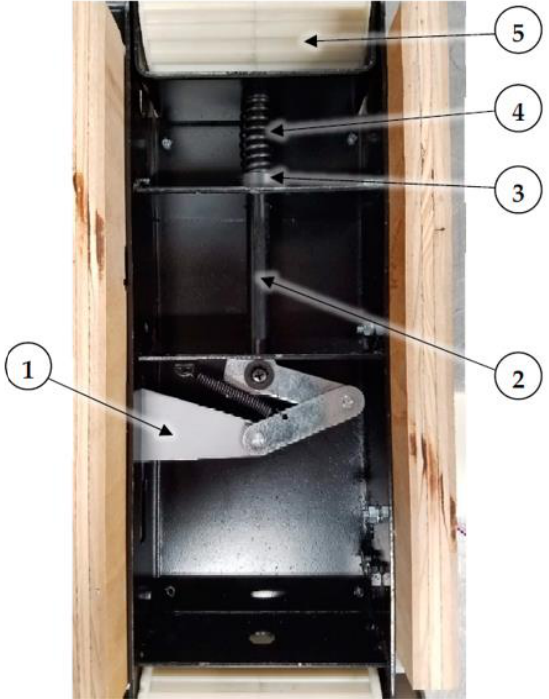
Figure 6. Bottom view of dust generator showing (1) belt tension release lever, (2) connecting link, (3) spacer, (4) spring, and (5) idler pulley (shown for